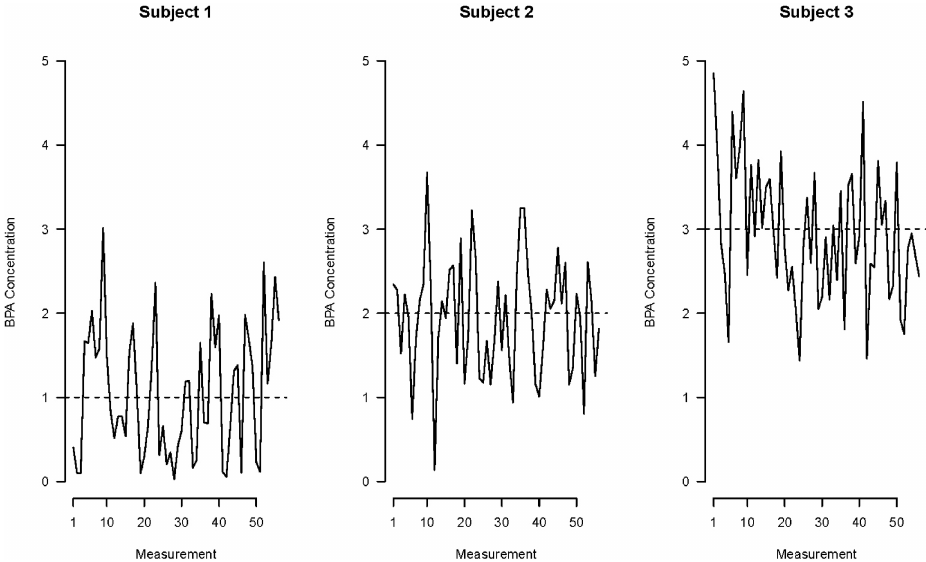
Fig 1. Urinary bisphenol A concentrations (ng/mL) from three hypothetical subjects over the course of approximately one week. Dashedlines represent averageBPA concentration of all urine samplesfor each individualand were set arbitrarily to 1, 2, and 3 ng/mL. The x-axis denotes the sequential number of the collectedurine sample. The figure illustrates that a singlerandomly chosen sample from an individualmay not representtheir averageexposureand could misclassify them as havinglower or higherexposurethan their true exposure. Moreover, a single urine sample cannot reliablydistinguishdifferencesin BPA concentrations betweenindividuals becausethe within-person variationin BPA concentrations is greater than the between- personvariation. BPA, bisphenolA.